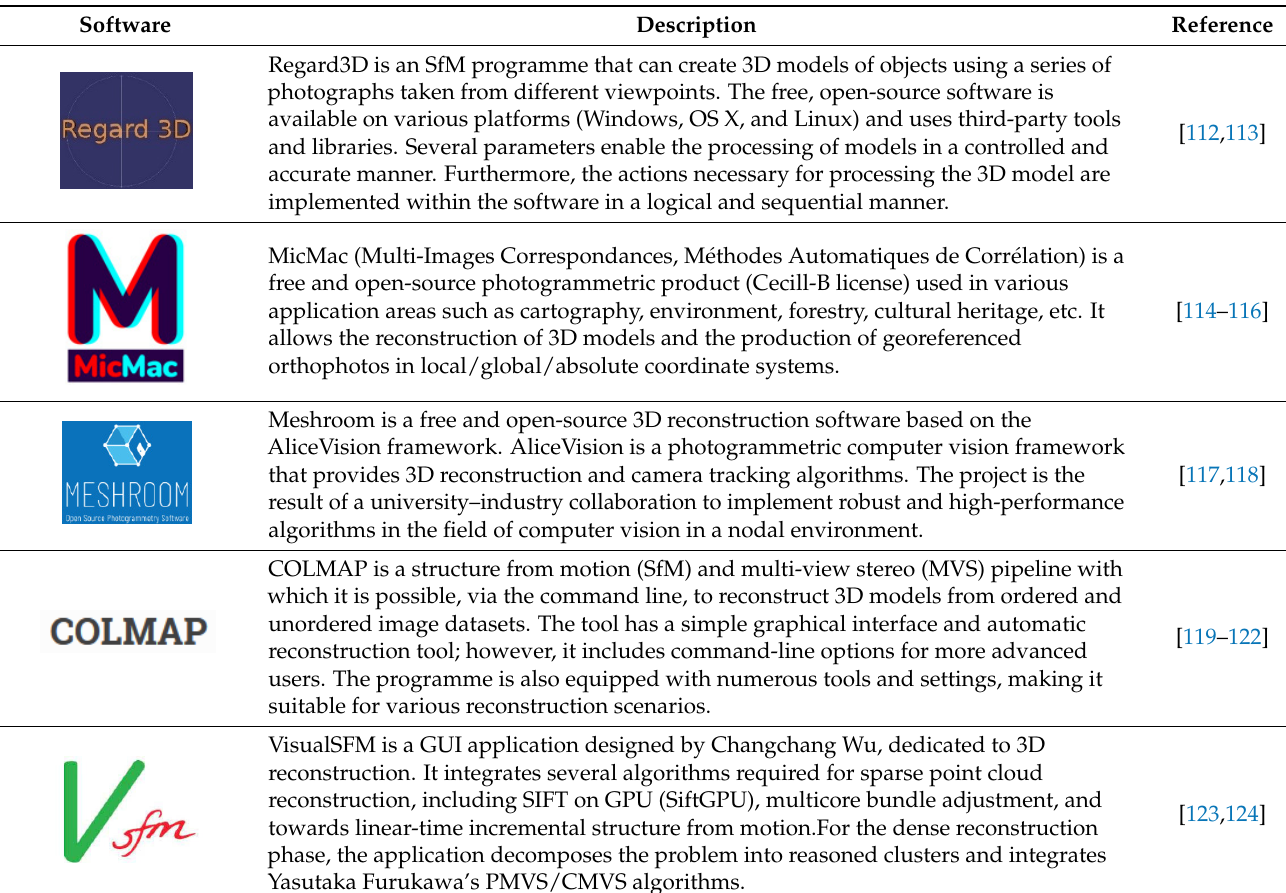
Table 8. Main open-source software.